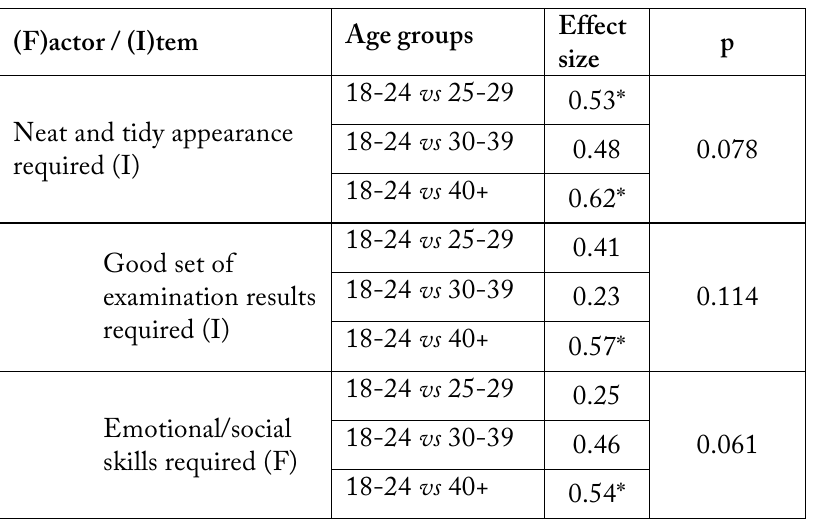
Table 4: Differences between the age